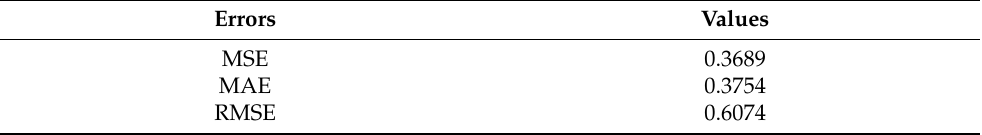
Figure 13. ( a ) Error and ( b ) relative error of the prediction of solar radiation using ARMA (3,3) (for a summer day). Table 6. MSE, MAE, RMSE of the prediction of solar radiation for a summer day.